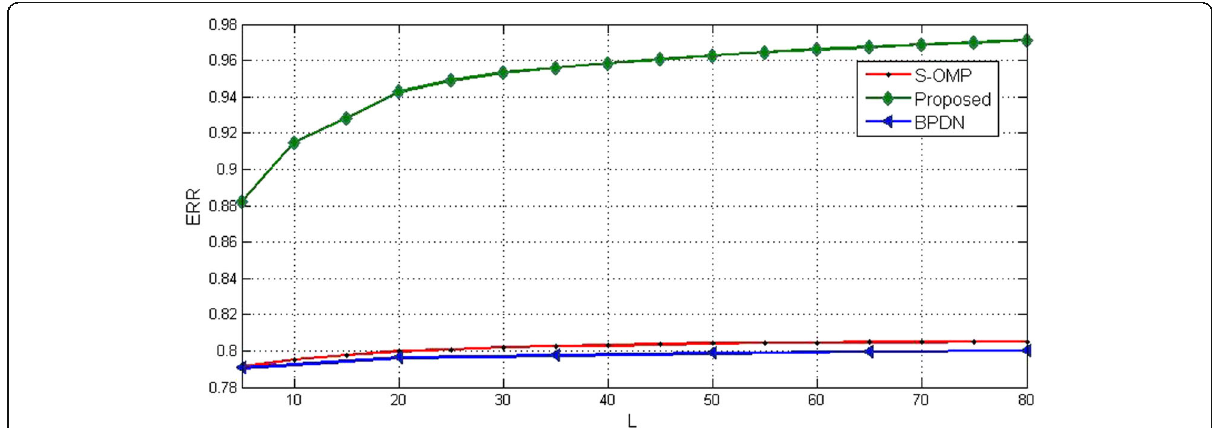
Fig. 1 Effect of number of snapshots on the recovery rate for SNR = 30 dB, M = 30, and K =